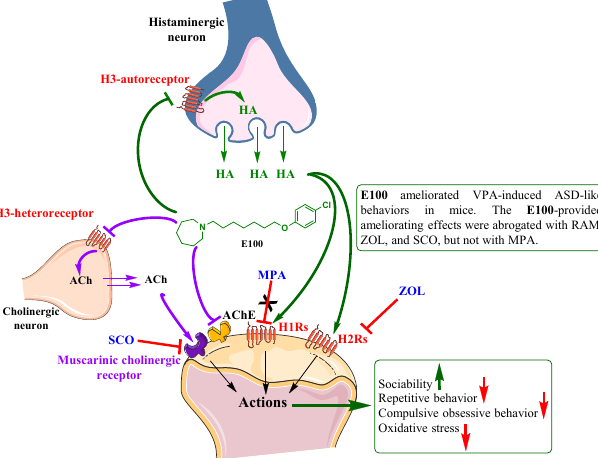
Figure 7. Putative mode of action of E100 by blocking the acting auto- and hetero histamine H3 receptors (H3Rs) and inhibition of the acetylcholine esterase enzyme (AChE). Regulating the release of brain histamine (HA) and acetylcholine (ACh), respectively and inhibiting the metabolism of ACh.